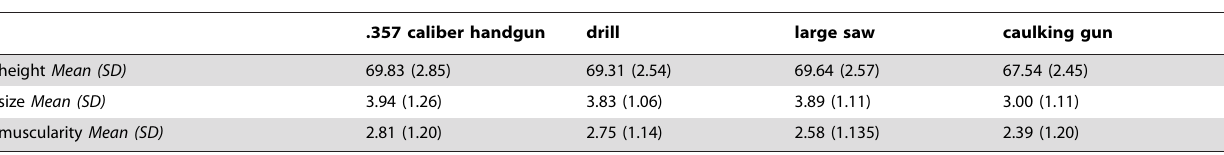
Table 3. Estimated Height, Size, and Muscularity (Study